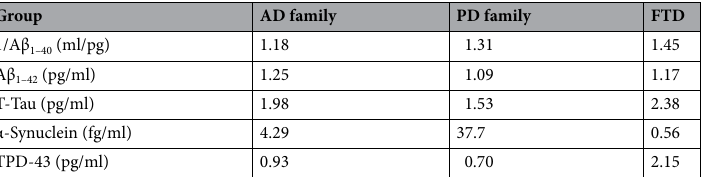
Table 2. Effect sizes of measured plasma biomarkers in subjects with neurodegenerative diseases. AD family patients with amnestic cognitive impairment or Alzheimer’s disease, PD family Parkinson’s disease patients with or without dementia.